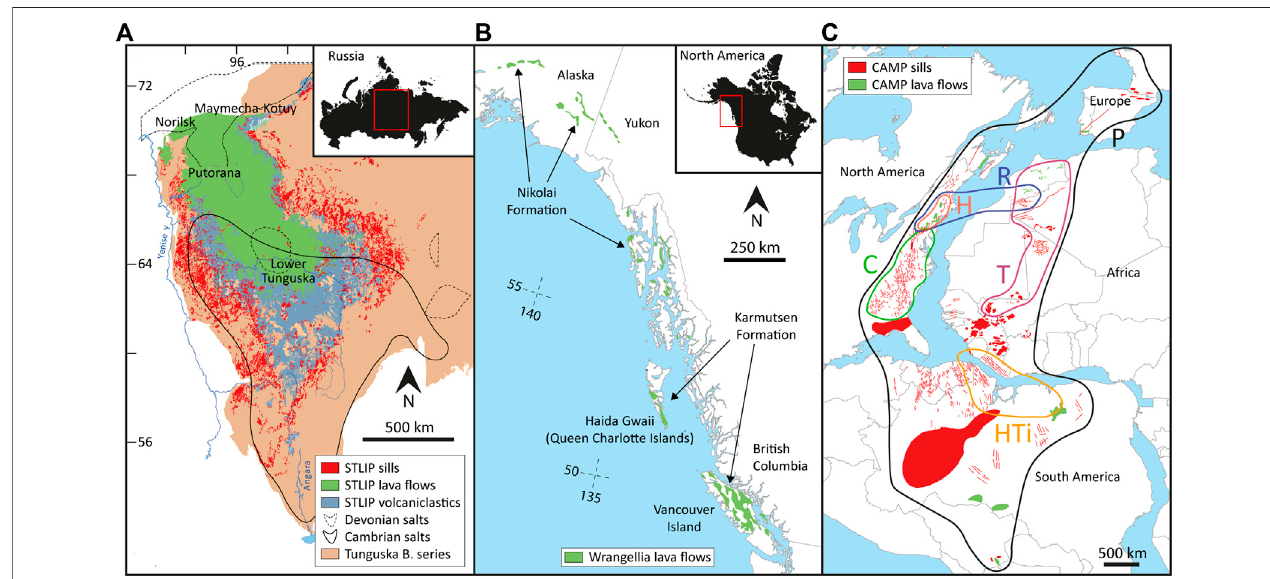
FIGURE 1 | Simpli fi ed sketches of (A) the Siberian Traps (modi fi ed after Svensen et al., 2018) (B) the Wrangellia (modi fi ed after Lassiter et al., 1995), and (C) the CAMP (modi fi ed after Capriolo et al., 2020). (C) Coloured lines represent the geographic distribution of the six geochemical groups of the CAMP magmas identi fi ed by Marzoli et al. (2018): P=Prevalent, HTi=high-Ti, T=Tiourjdal, R=Recurrent, C=Carolina, H=Holyoke.